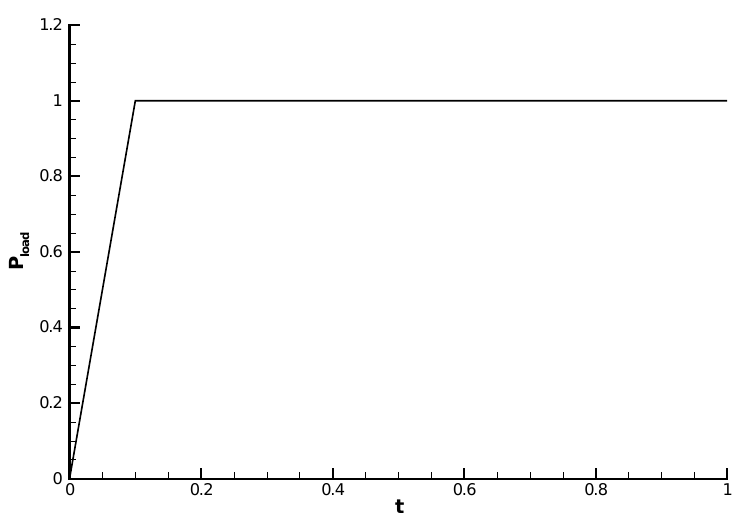
Figure 6. Surface loading of one-dimensional consolidation problem.